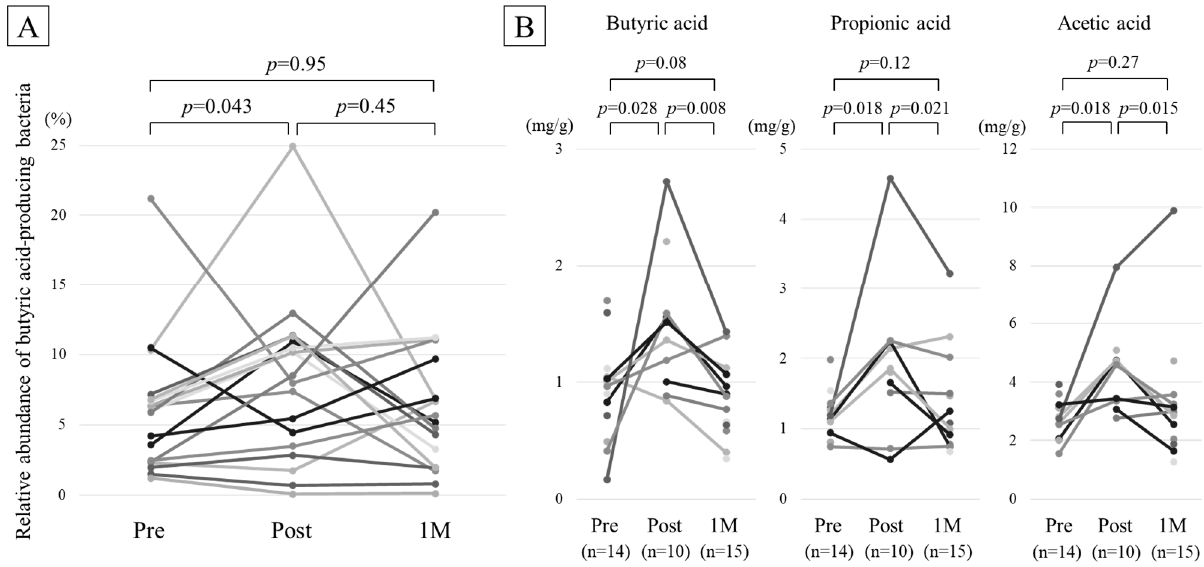
Figure 2. Changes in the composition of butyric acid-producing bacteria and fecal butyric acid concentration due to intake of functional barley. ( A ) Relative abundance of butyric acid-producing bacteria. ( B ) Concentrations of fecal butyric, propionic, and acetic acids. Points are not connected in the instances of insufficient data.